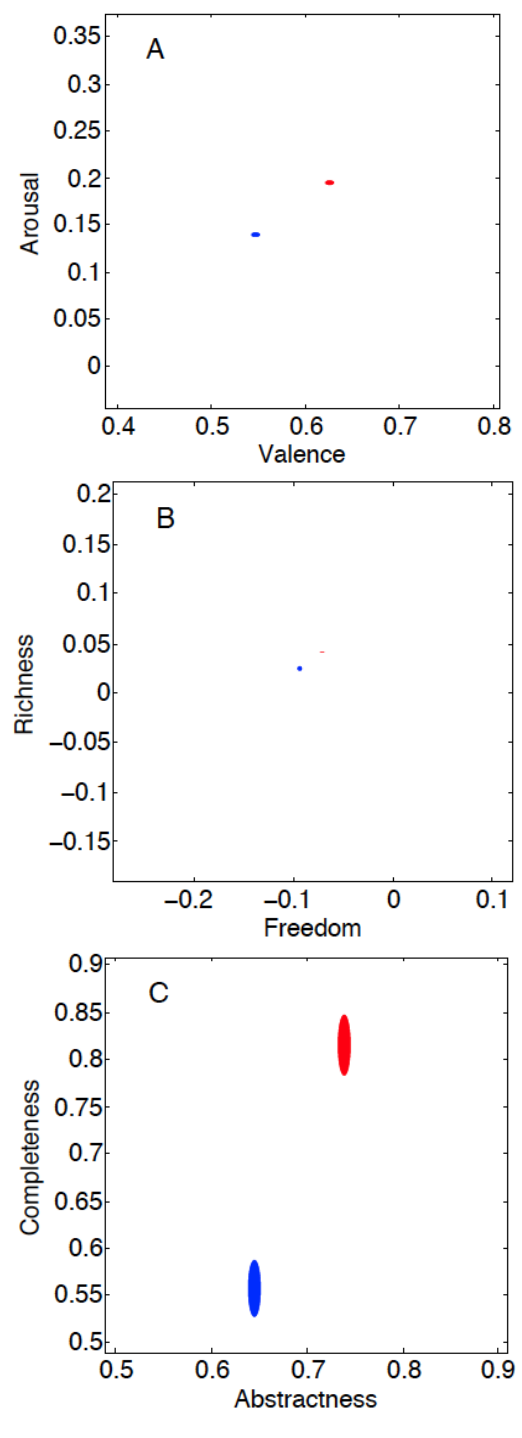
Figure 8. Semantic measures of documents from the Journal of Neuroscience. Filled ovals show the means with standard errors. Blue: Brief communications; Red: